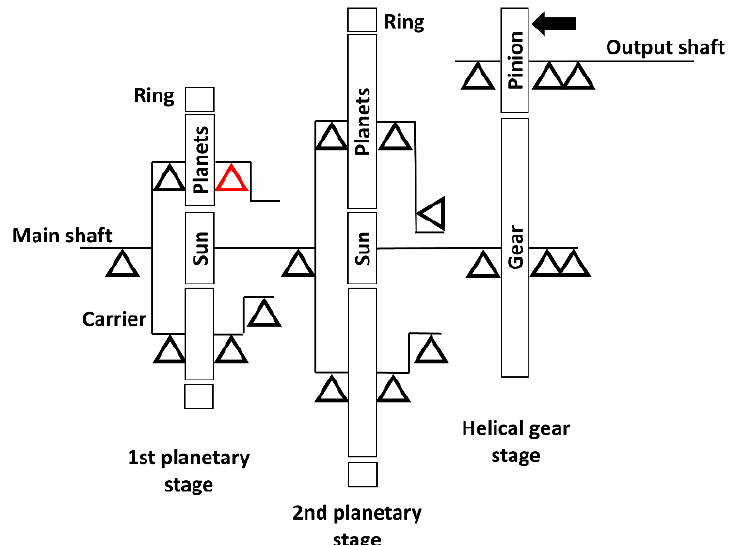
Figure 1. Schematics of the three-stage gearbox, with the damaged bearing highlighted in red and the position and direction of the output channels indicated by the black arrow.